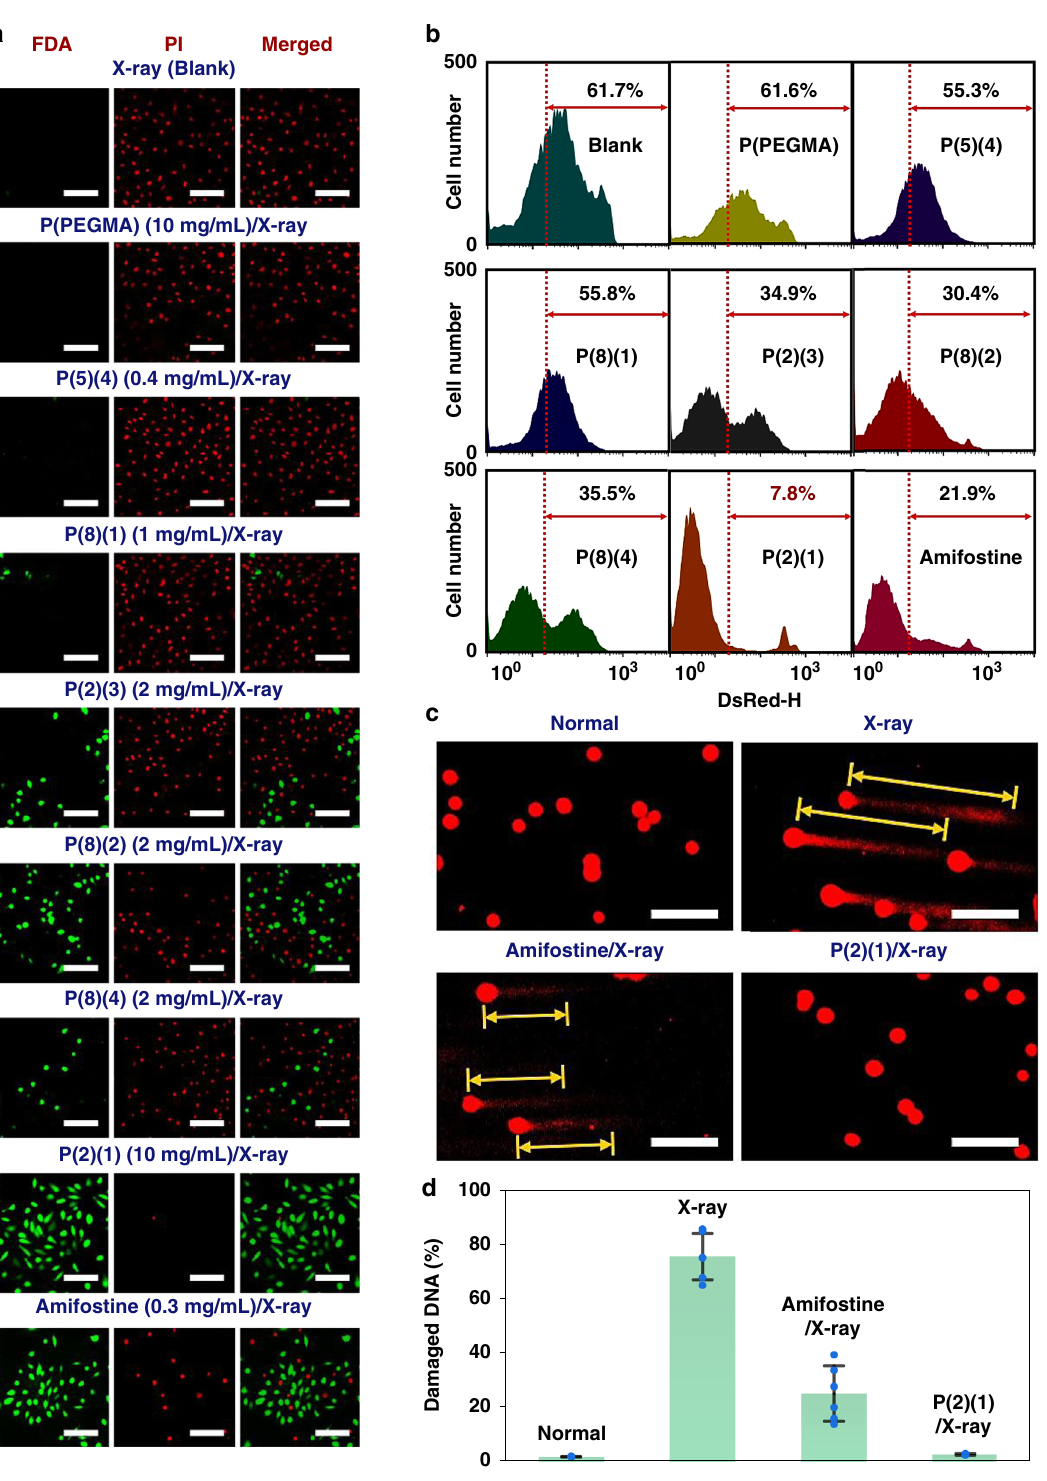
Fig. 5 Cell experiments to evaluate radioprotection ability of different compounds. a FDA/PI double staining of L929 cells after exposure to 80 Gy X-ray radiation under different culture conditions. Scale bar = 100 μ m. This experiment was repeated three times independently with similar results. b Flow cytometry analysis of cell necrosis under different conditions. c Comet assay images of cells under different culture conditions. Scale bar = 200 μ m. d Damaged DNA (%) in the cells. The data are presented as mean values± SD ( n = 6 biologically independent cells). Source data are provided as a Source Data fi